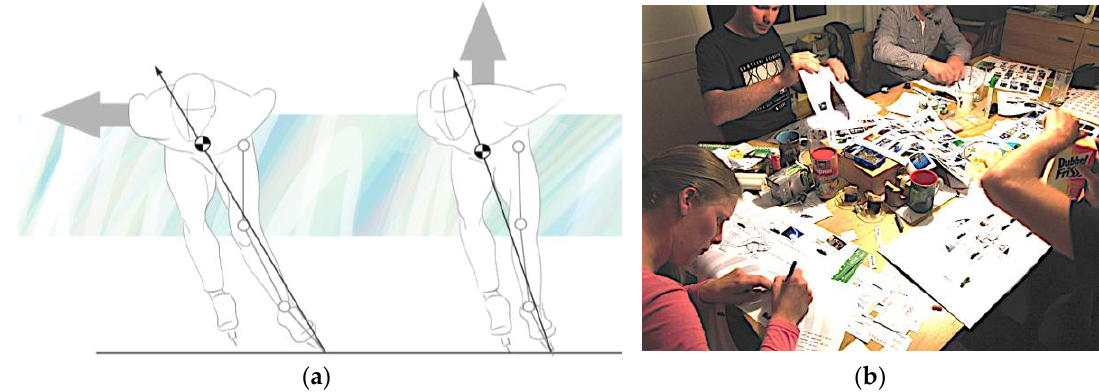
Figure 2. ( a ) Fall in the push-off phase; the skater needs to fall sideways in order to push off (and not up); ( b ) Picture of the participants in the focus group